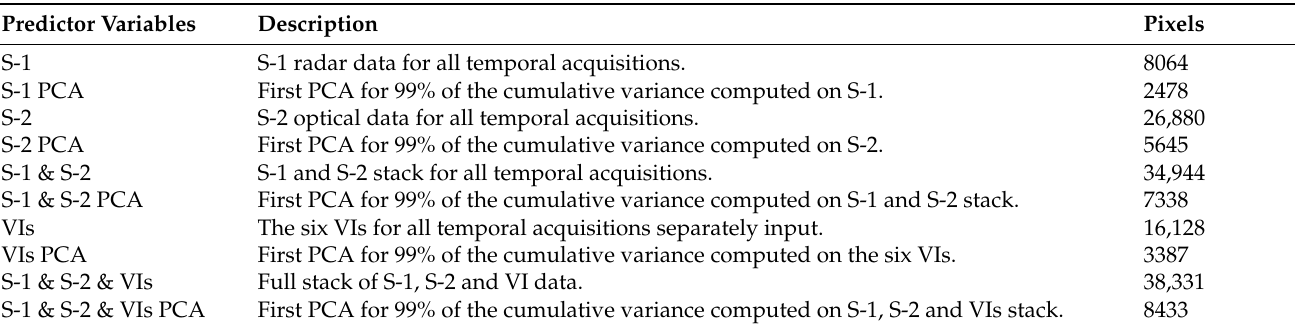
Table 2. List of inputs for 10 predictor combined variables used for predicting and mapping plant diversity. The pixels provide the number of variables for each